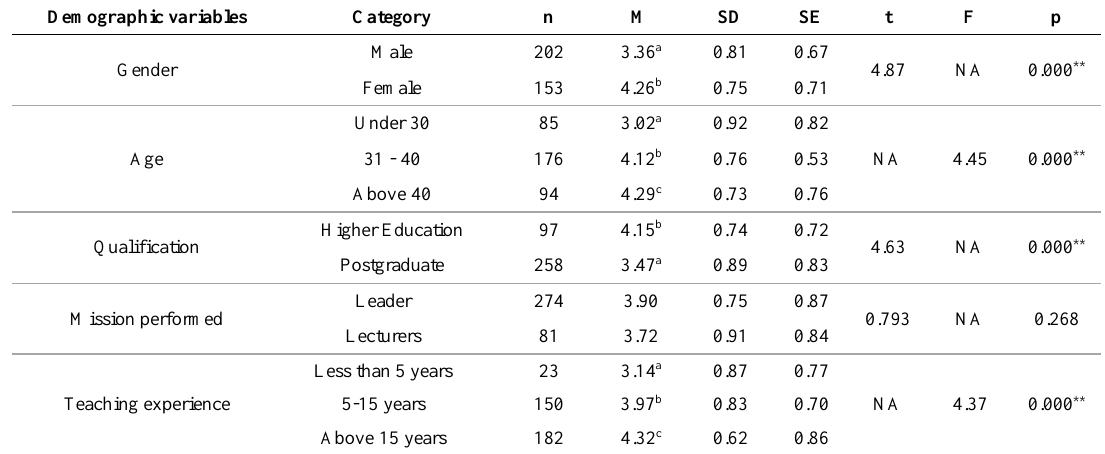
Table 6. The commitment of lecturers is based on demographic